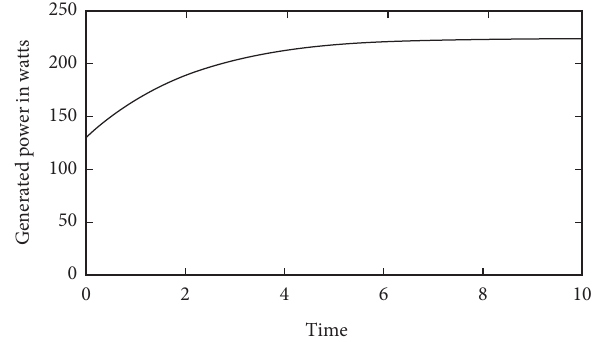
Figure 39: Generated power by the